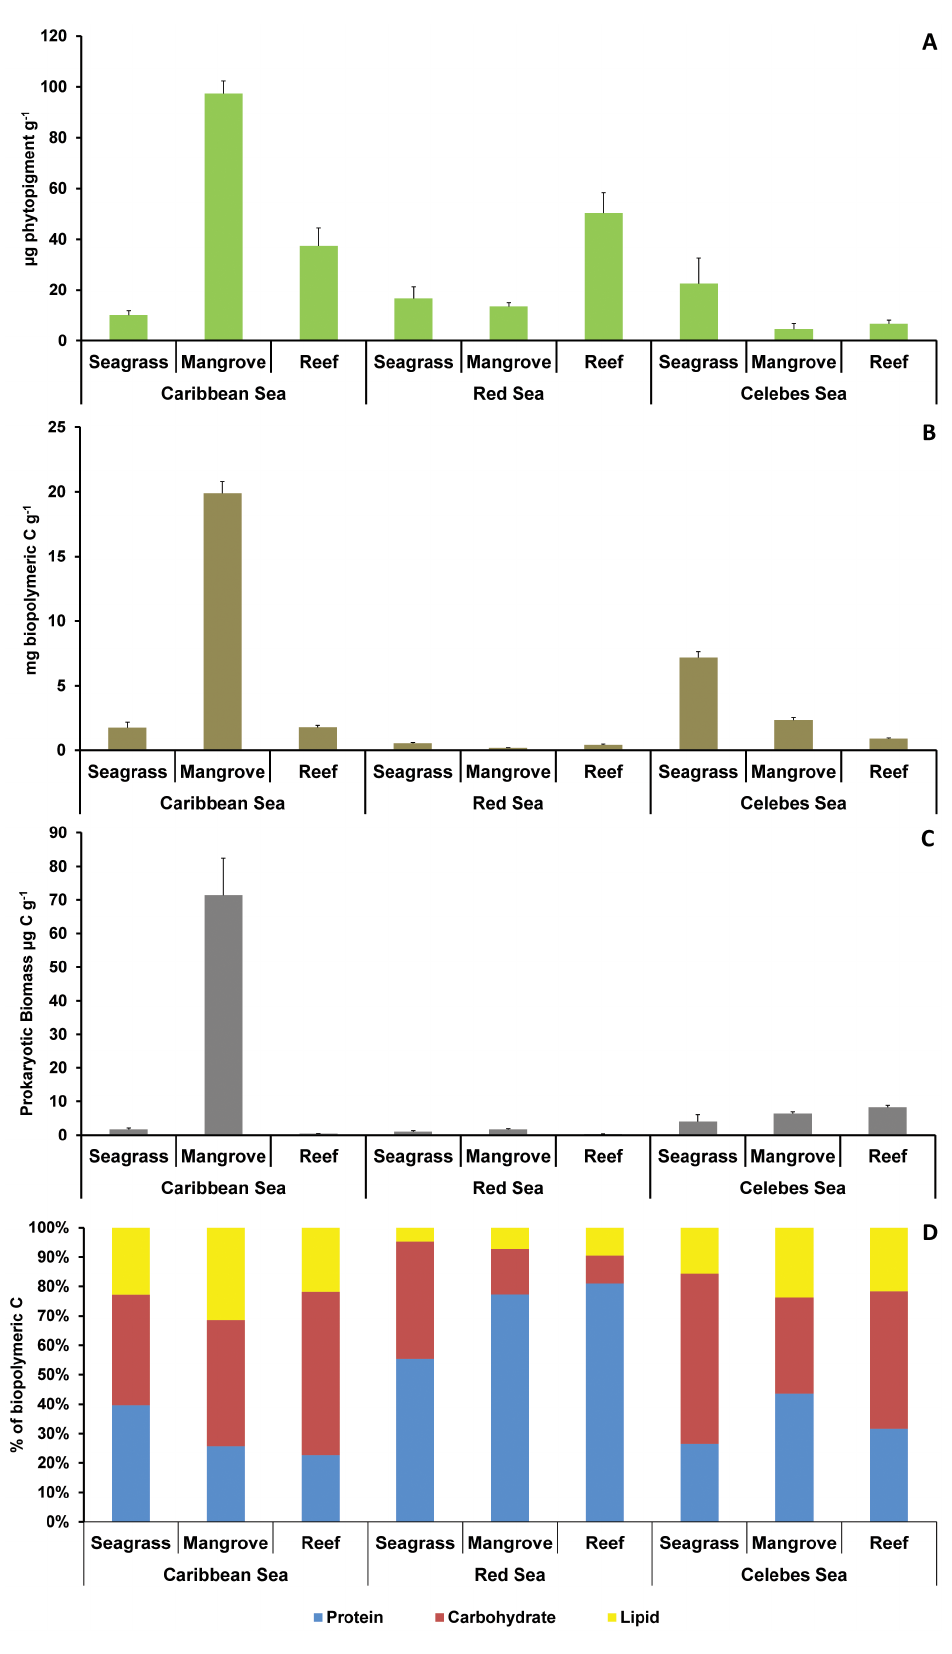
Figure 2. Biochemical composition of sedimentary organic matter. Reported are the concentrations of A) total phytopigments, B) biopolymeric carbon, C) prokaryotic biomass, and D) the biochemical composition (as percentage contribution of the biopolymeric carbon content)